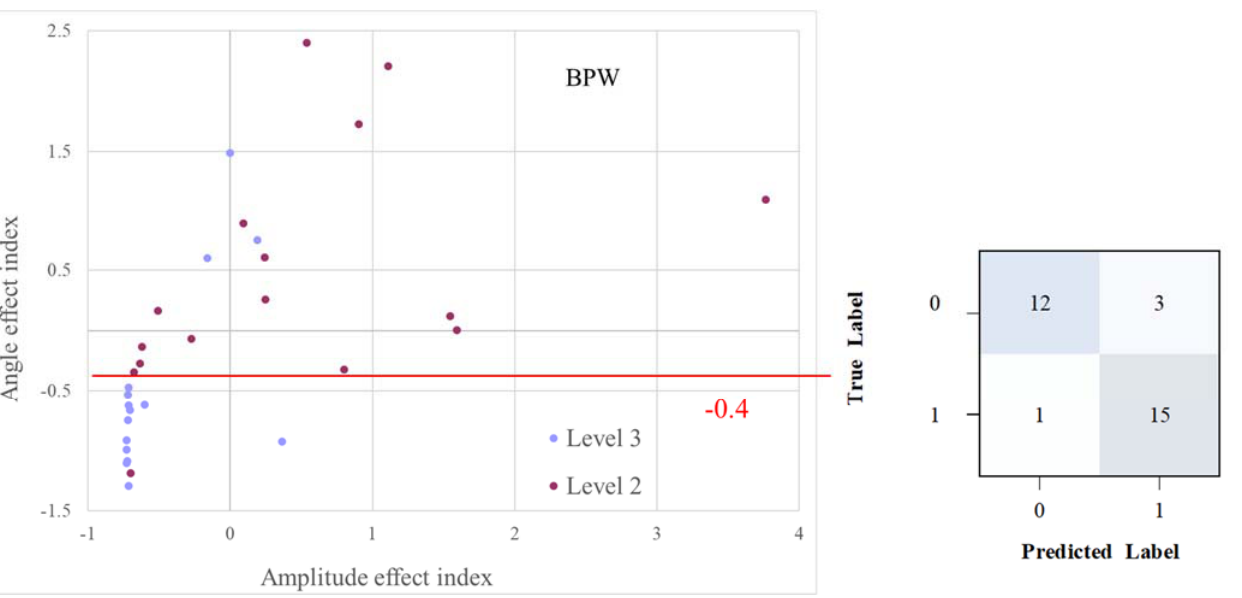
Figure 6. Comparisons of LDF spectral indices among the three groups. Data are mean and SD values. There were no significant differences in all frequency bands among the three groups. As illustrated in Figure 7, we can use BPW indices in distribution plots for the relative changes of pulse-effect indices to achieve almost perfect discrimination (AUC = 0.878) between Level 3 and Level 2.